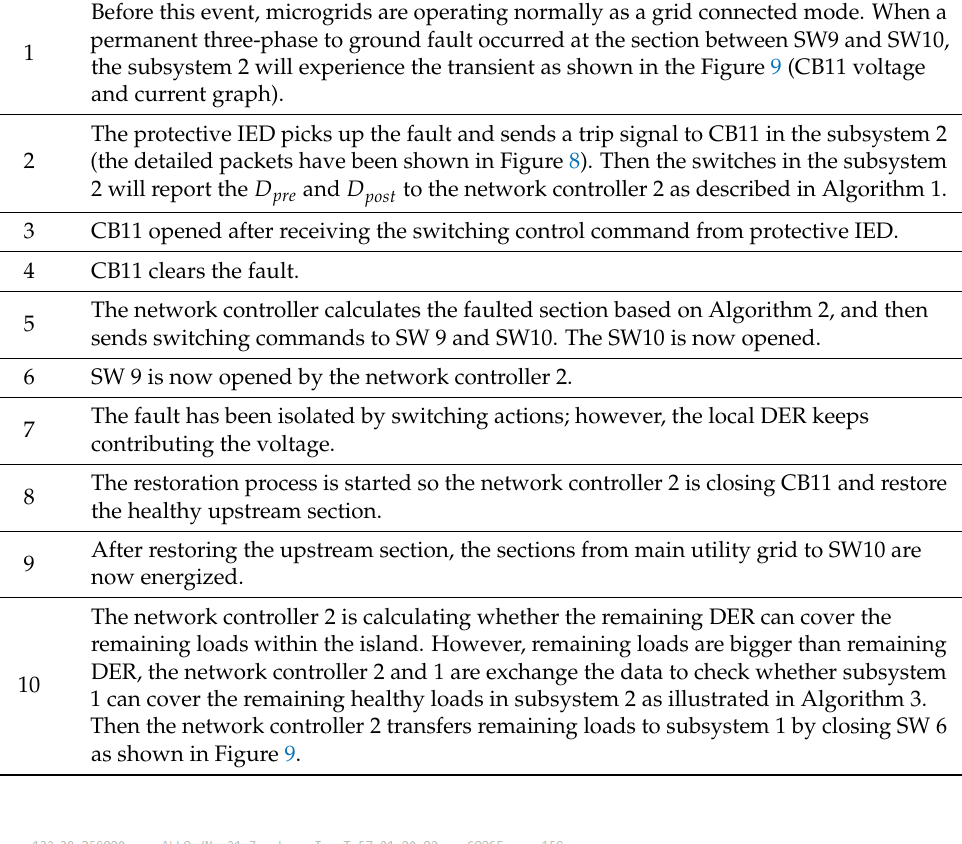
Table 3. Validation of F-FDIR.